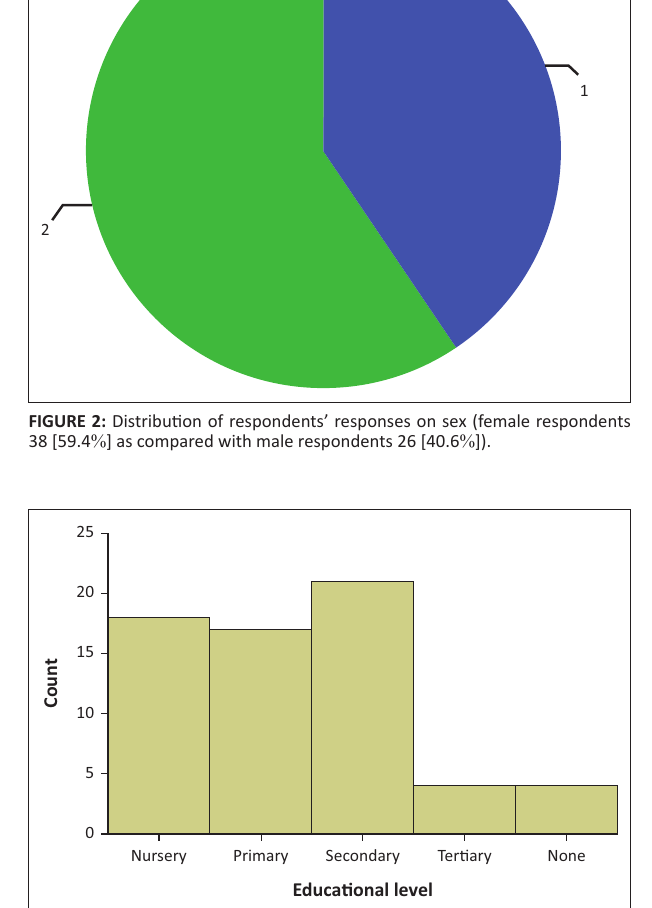
TABLE 1: Socio demographic characteristics of respondents. S. no.